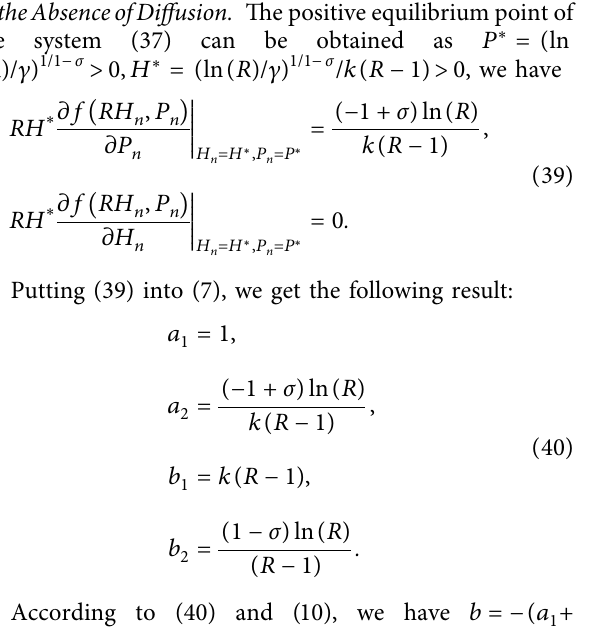
� 0 . 8 ,T � 1, the system (36) is 1